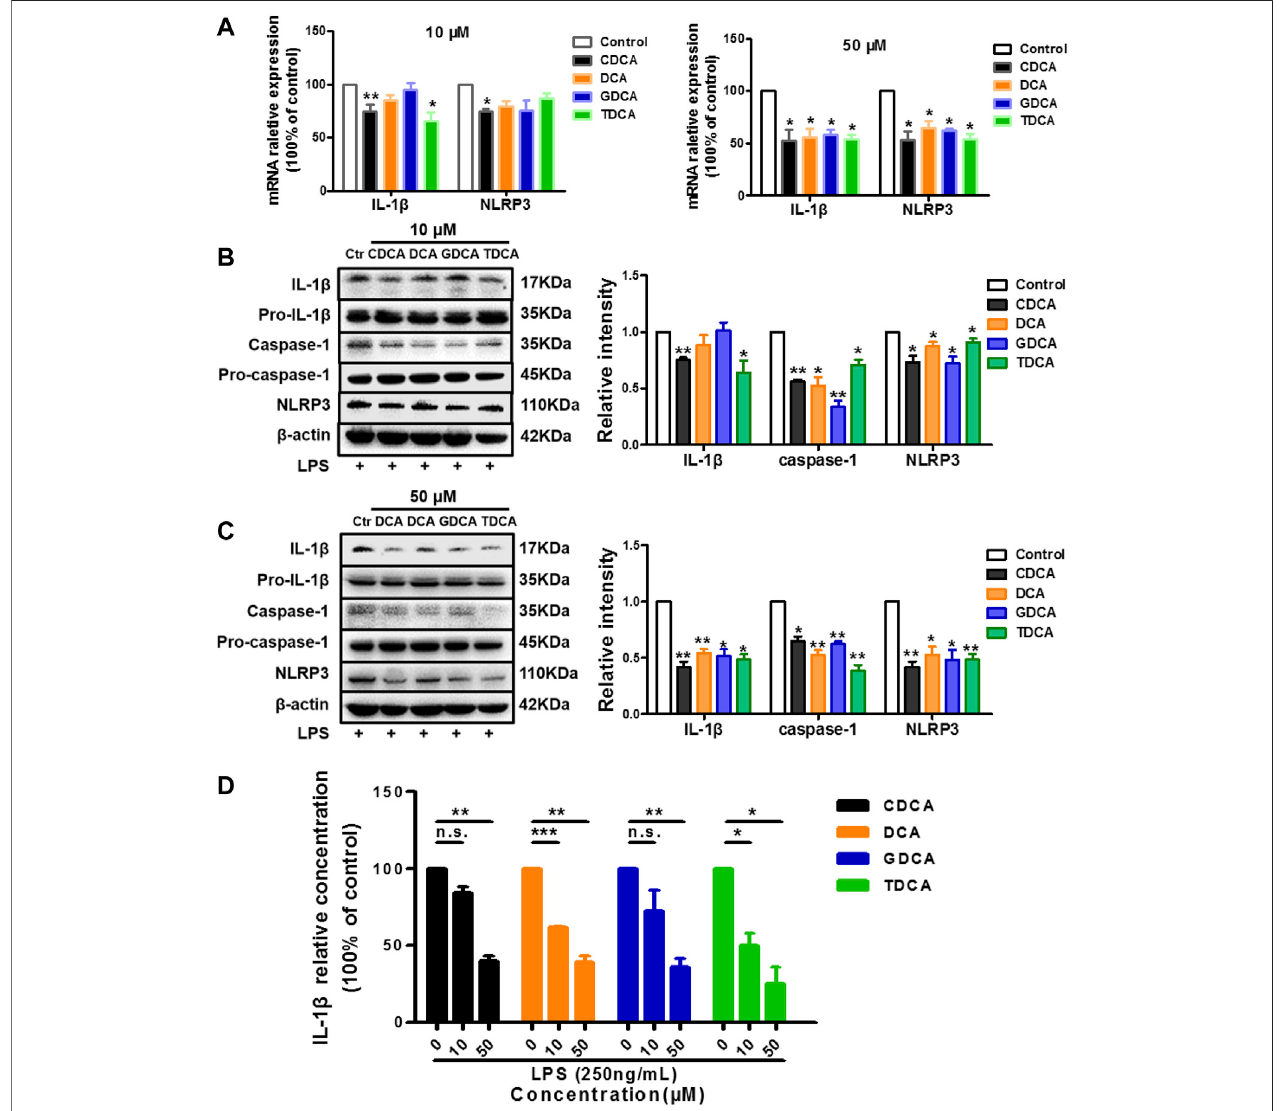
FIGURE2 | BAsinhibit NLRP3 in fl ammasomein in fl ammatoryconditions in macrophages. Prior tothe BA treatment, cells werepretreated with250 ng/ml LPS for 1 h. (A) RelativemRNAexpressionofNLRP3andIL-1 β withBAsat10or50 μ M.IL-1 β ,caspase-1,andNLRP3proteinlevelsaftertreatingwithBAsat10 μ M (B) and (C) 50 μ M. (D) IL-1 β inculturemediumaftertreatingwithBAsat10and50 μ M.Dataarepresented asmean±SD( n =3).StatisticalanalysiswasperformedusingStudent ’ s t test (* p < 0.05, ** p < 0.01, *** p < 0.001, and n.s., not signi fi cant).